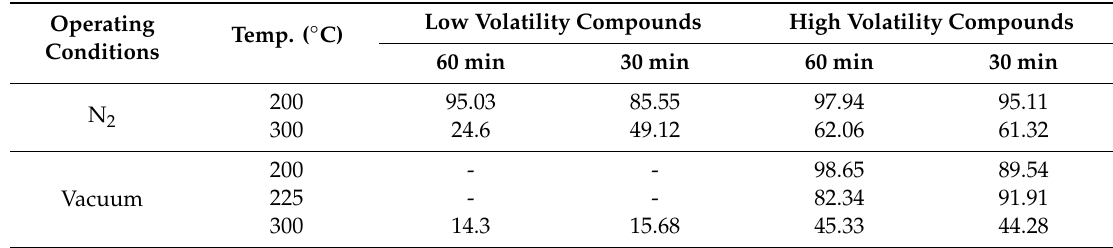
Table A1. The moisture content of high and low volatility compounds at various operating